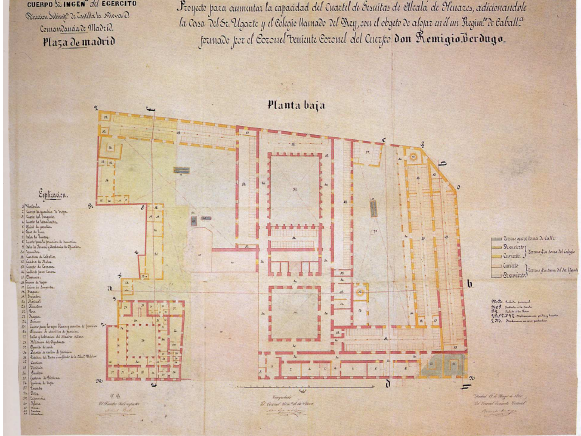
Figure 7. Reform cavalry barracks (former College of the Society of Jesus) by Military Engineer D. Remigio Berdugo,